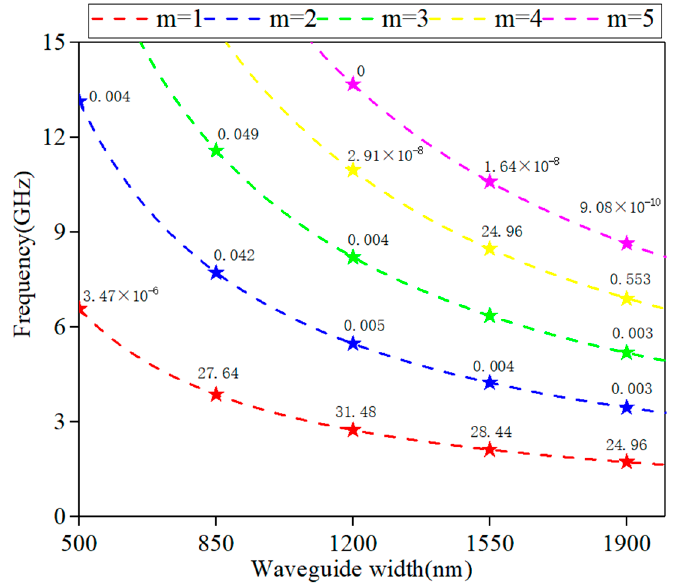
Figure 6. The relationship between the coupling efficiency of the Brillouin-suspended laser and the frequency change with the waveguide width. Where m represents the order of the acoustic mode, the number in the table represents the coupling efficiency and its unit is kHz.